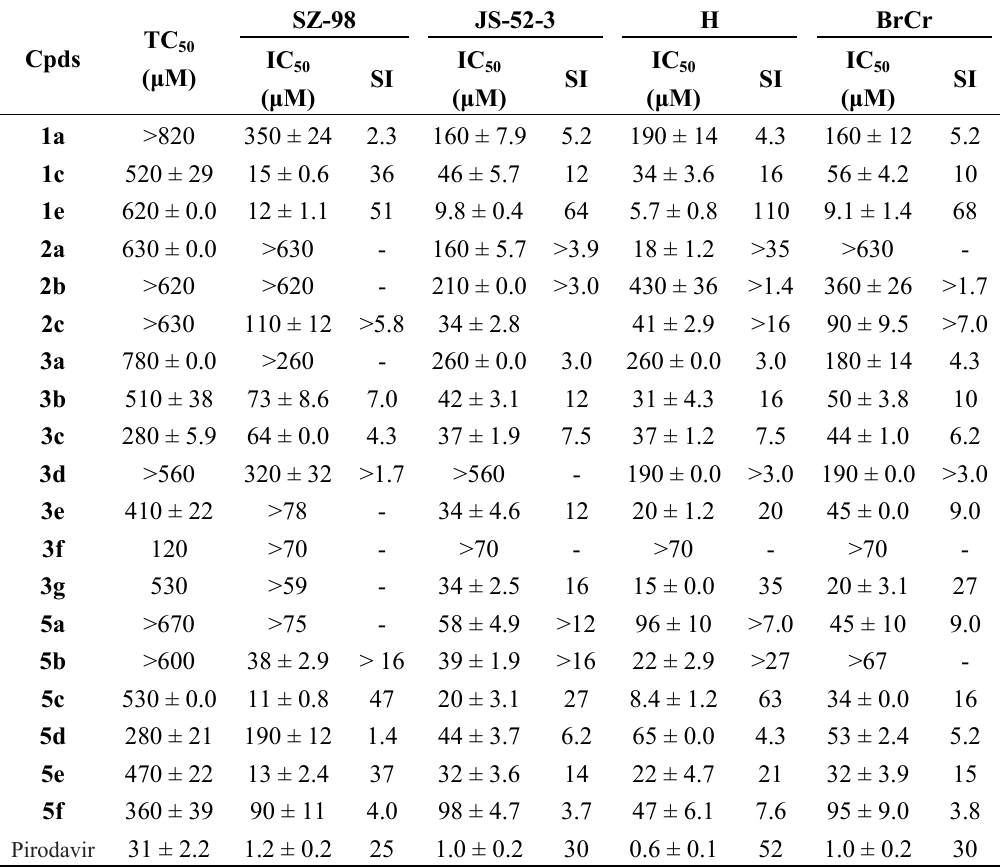
Table 1. The activity of the synthesized N -phenylbenzamide derivatives against several strains of EV